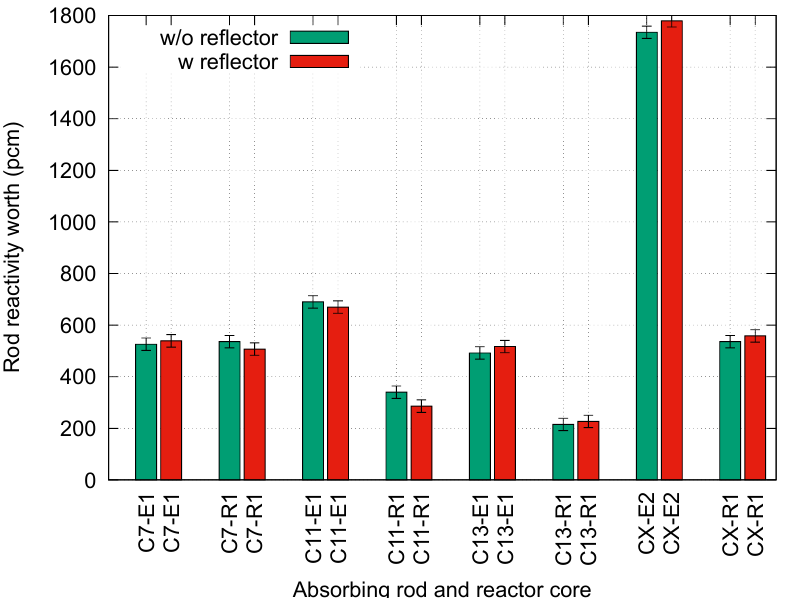
Figure 4: Reactivity compensated by rods in VR-1 cores with and without the stainless steel